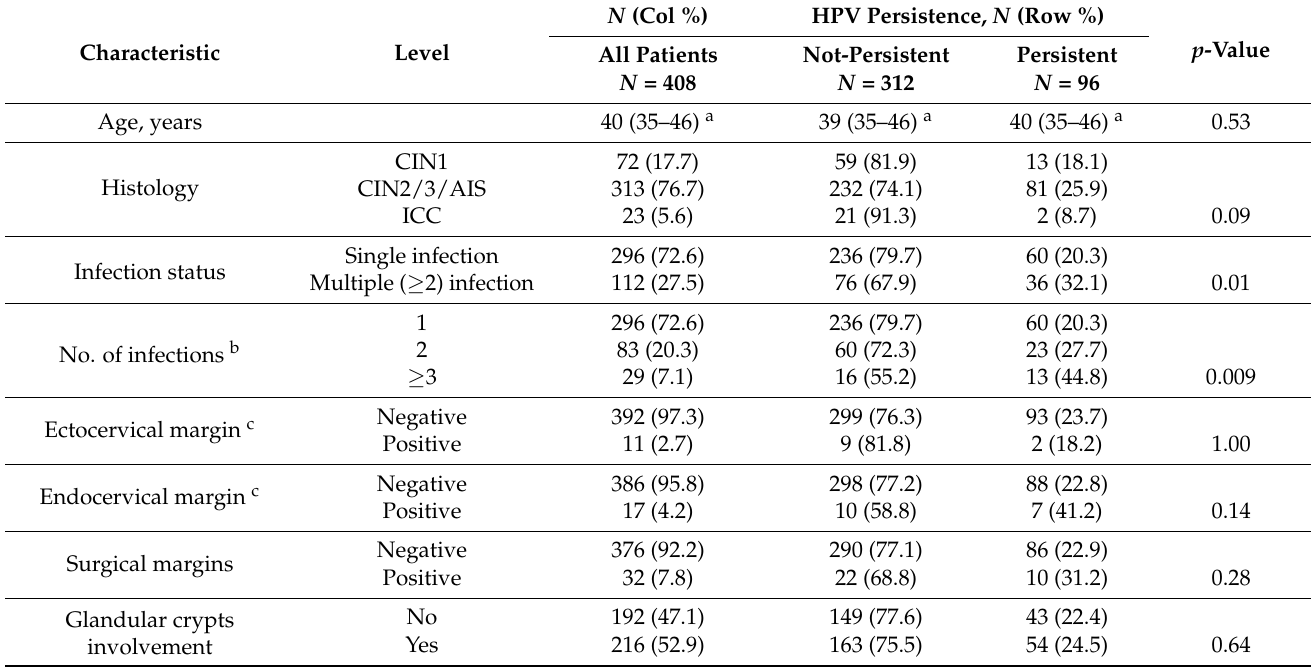
(Table 1). The proportion of persistence was significantly higher for patients with multiple infection (32.1%) at baseline compared to patients with single infections (20.3%) ( p = 0.01). HPV persistence also showed a significantly ( p = 0.009) monotone inverse relationship with the number of genotypes detected at baseline irrespective of the genotype. Among 96 persistent patients, 60 (20.3%) had only one genotype, 23 (27.7%) had two different genotypes, and 13 (44.8%) had three or more different genotypes, respectively (Table 1). Table 1. Patients’ characteristics at baseline and HPV persistence status at 3–9 months (first follow-up visit) from baseline. N (Col %) HPV Persistence, N (Row %) p -ValueAll Characteristic Level